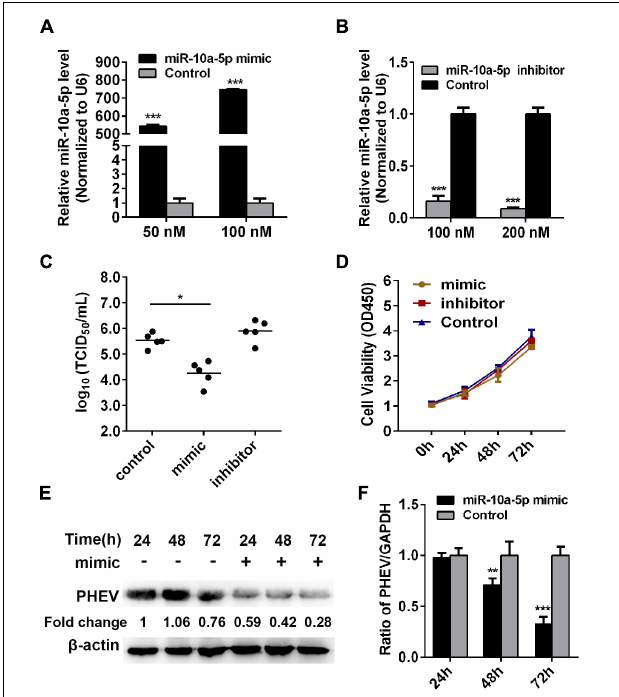
FIGURE 2 | Abundant miR-10a-5p suppresses the replication of porcine hemagglutinating encephalomyelitis virus (PHEV). (A) N2a cells were transfected with different concentrations of miR-10a-5p mimic for 24 h, and then the expression of miR-10a-5p was analyzed by qRT-PCR and normalized to U6. (B) N2a cells were transfected with 100 or 200 nM miR-10a-5p inhibitor, and miR-10a-5p level was detected by qRT-PCR. (C) N2a cells pre-transfected with miR-10a-5p mimic, miR-10a-5p inhibitor, or miRNA NC were seeded in 96-well plates followed by PHEV infection. The cytopathic effect was monitored for 24 to 96 h. The virus titers were determined by TCID 50 /ml and calculated according to the Reed–Muench method. (D) Cell Counting Kit- (CCK-8) assay was performed to determine the cell proliferation at the indicated times. (E) N2a cells were pre-transfected with 100 nM of miR-10a-5p mimic and then infected with PHEV at 2 × 10 6 TCID 50 /ml. The housekeeping gene for normalization. Data are shown as means ± SD of at least three independent experiments. * p < 0.05; *** p < 0.01.